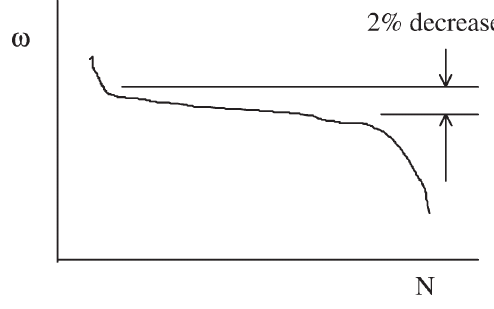
Fig. 7. Typical ! – N curve with a defined settling